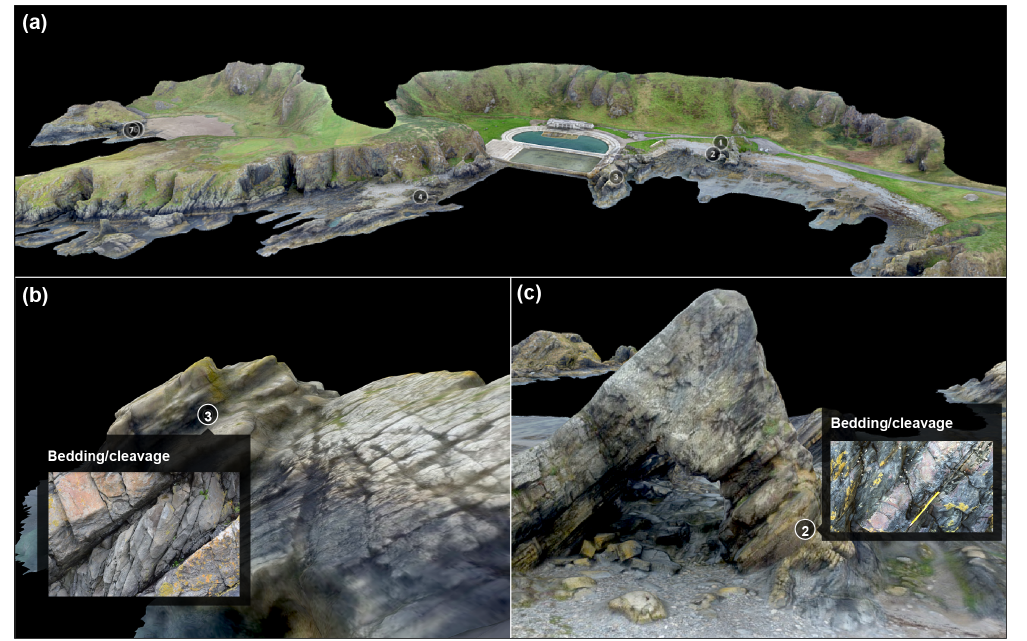
Figure 3. Virtual field site and outcrops. The panels show (a) the whole field site, and numbered annotations magnify the sites in greater detail, with a higher-resolution field photograph pop-up for the student, as shown in (b) , and in panel (c) , the annotation labelled 2 links to a detailed virtual outcrop model of the bedding–cleavage